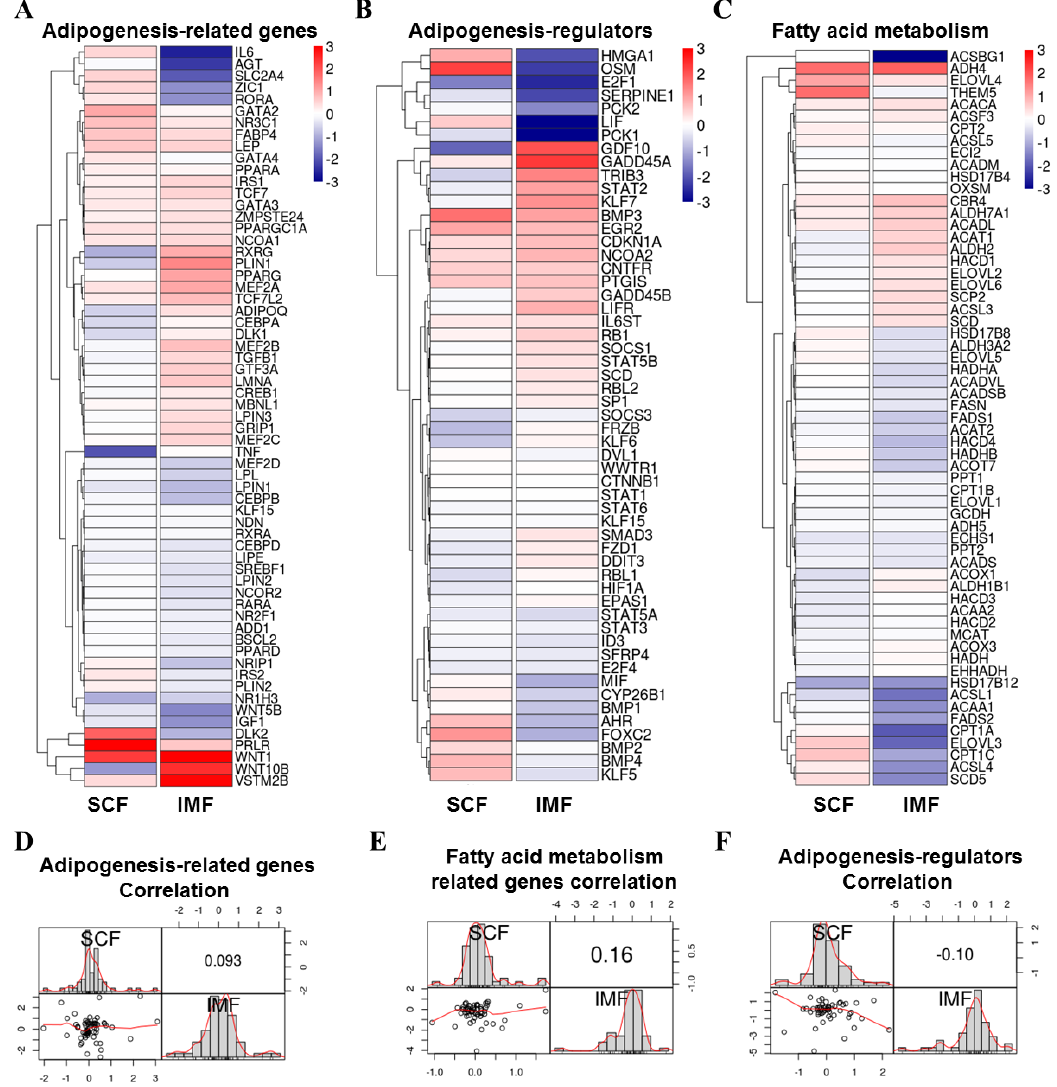
Figure 4. Comparison of adipogenesis genes of IMF and SCF adipocytes upon LKB1 overexpression. ( A – C ) Heatmap of log2 (fold change) values of adipogenesis-related genes ( A ),